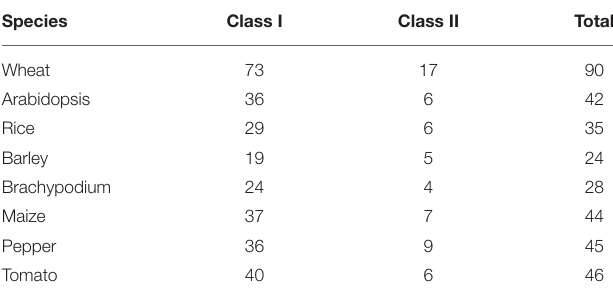
TABLE 1 | Comparison of the abundance of LBD genes in different plant